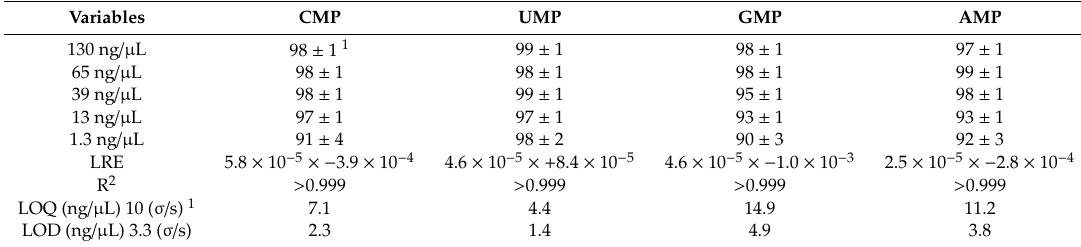
Table 1. Results of the calibration curves: recovery percentage as ratio of the recovered amount from HPLC vs. the loaded one, results of the regression analysis, LRE (Linear Regression Equation) LOD (limit of detection) and LOQ (limit of quantification).